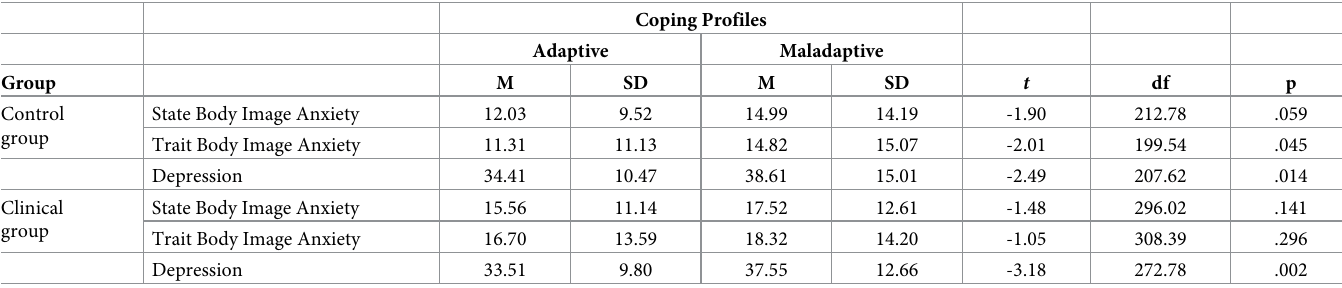
Table 4. Mean values of body image anxiety and depression in group with adaptive coping and group with maladaptive coping.